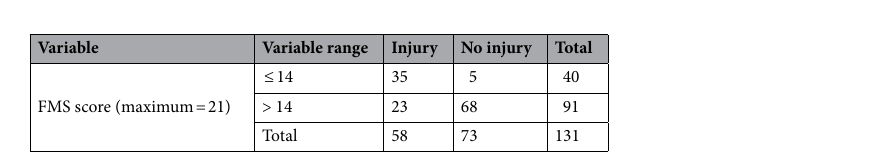
Table 4. Association between injury risk and FMS composite